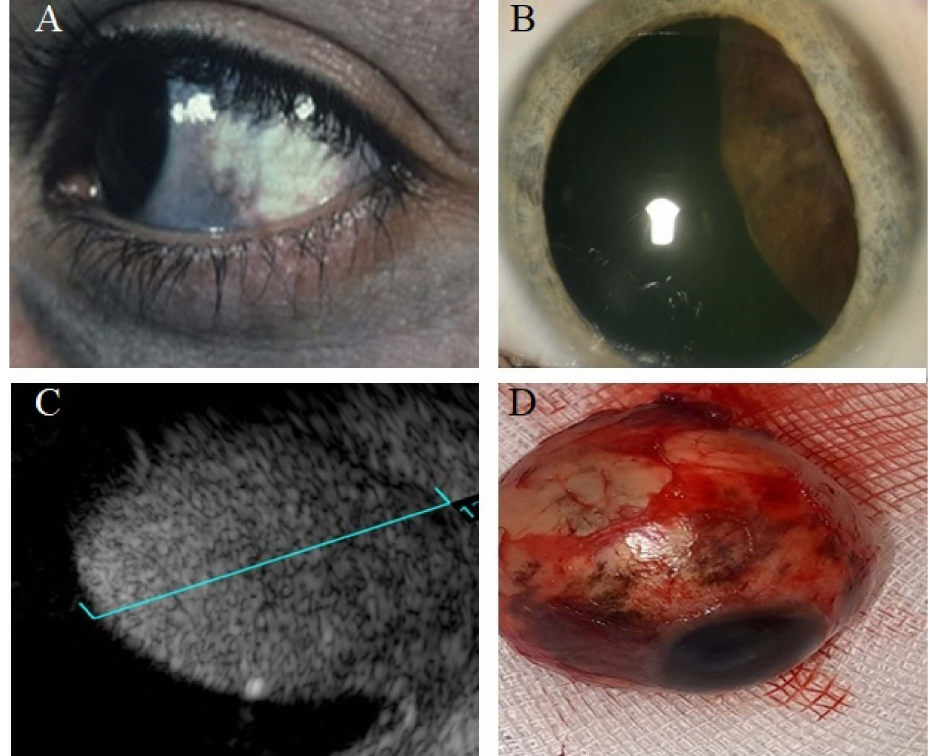
Figure 5. Patient with oculo-dermal melanosis ( A ) was found to have retrolenticular melanotic mass ( B ), which was found to be large choroidal melanoma (13 mm thick) with ciliary body involve- ment ( C ). This eye was enucleated and shown to have scleral melanosis ( D